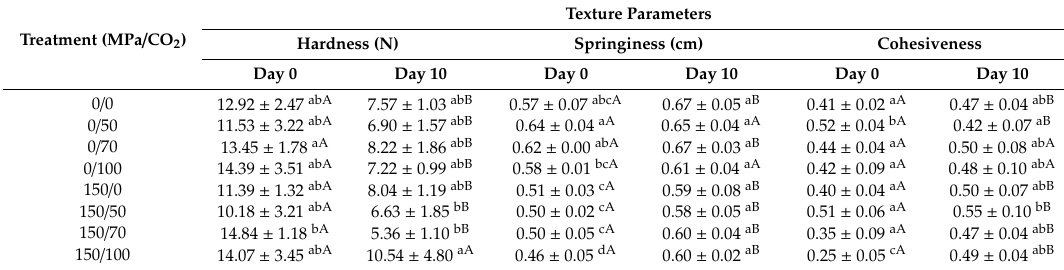
Table 4. E ff ect of treatment and refrigerated storage time on texture parameters of coho salmon fillets. Treatment (MPa / CO 2